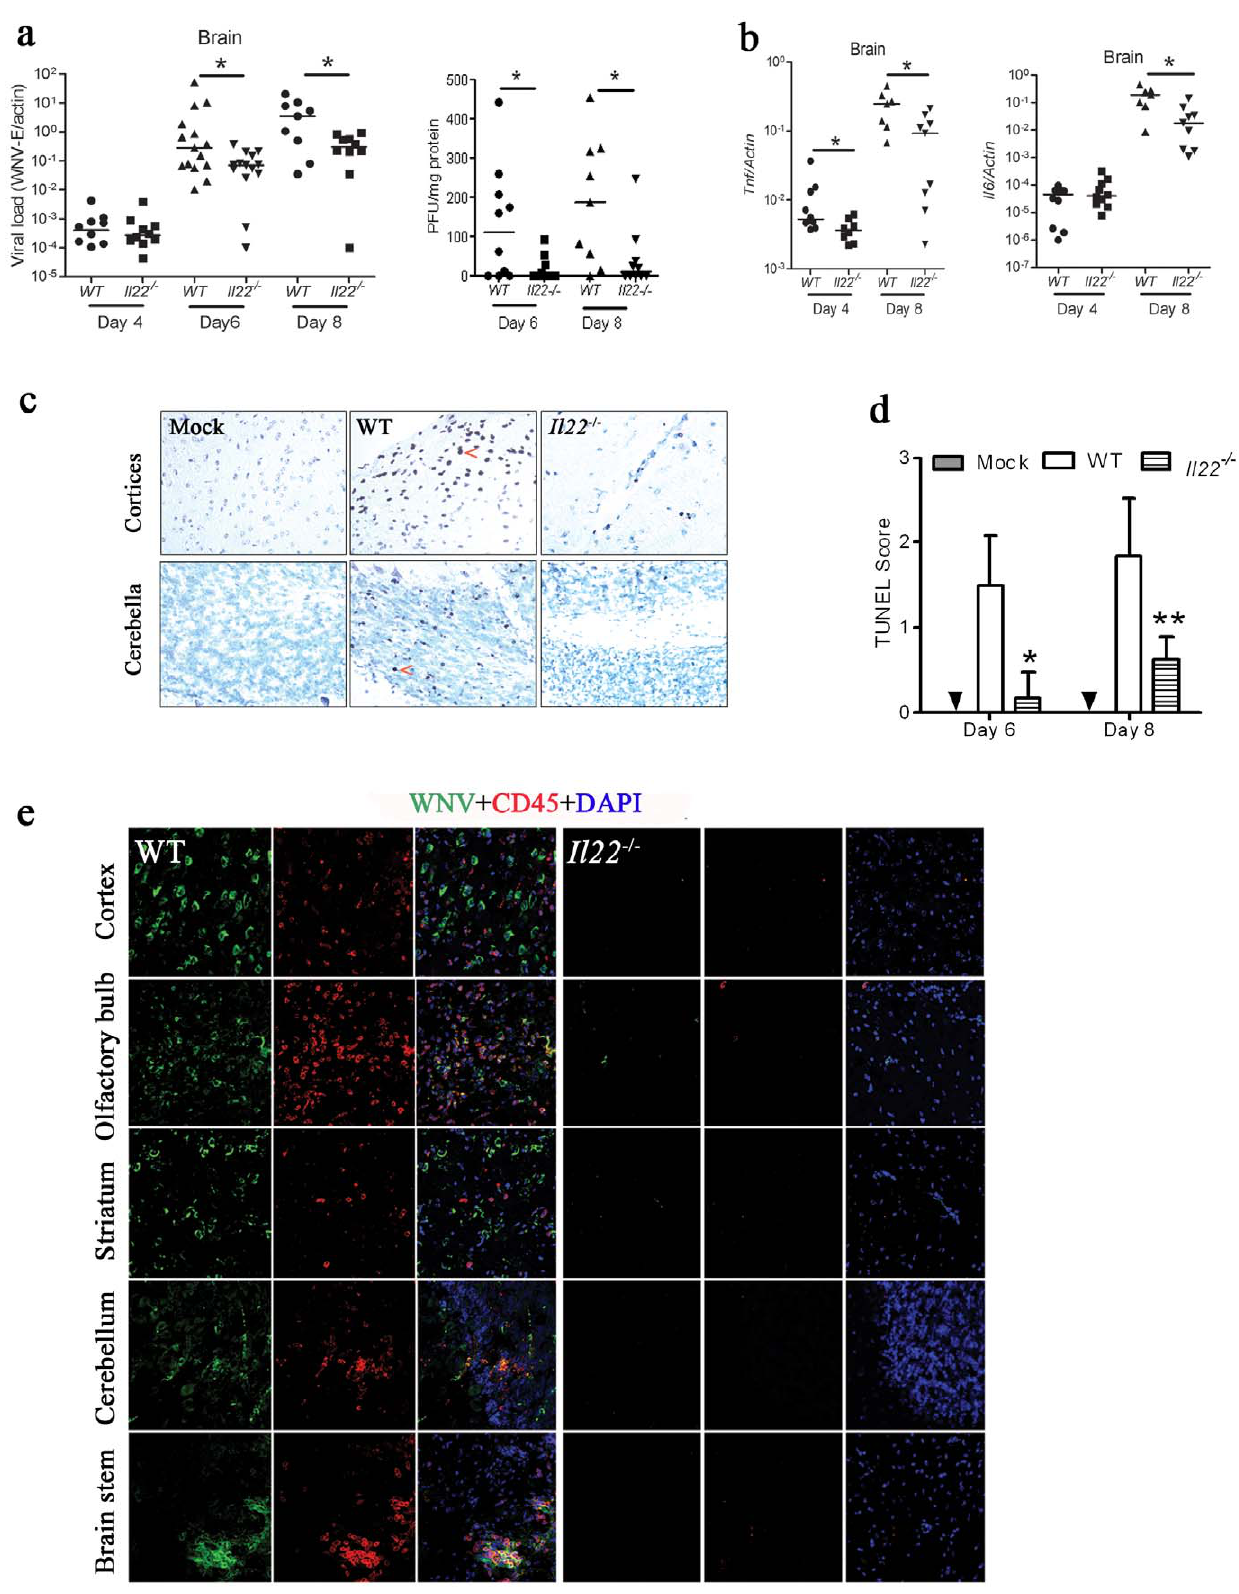
Figure 3. Phenotypic characterization of Il22 2 / 2 mice after WNV challenge. Mice were infected with 200 PFU of WNV via s.c. footpad injection. On days4, 6 and 8 p.i., a ) viral loads (shown by WNV-E expression and plaques per mg proteins) and b ) cytokine transcripts from the brain were quantified by q-PCR and normalized with mouse actin. c ) Paraffin embedded brain sections were reacted with TUNEL. Graphs indicate cerebral